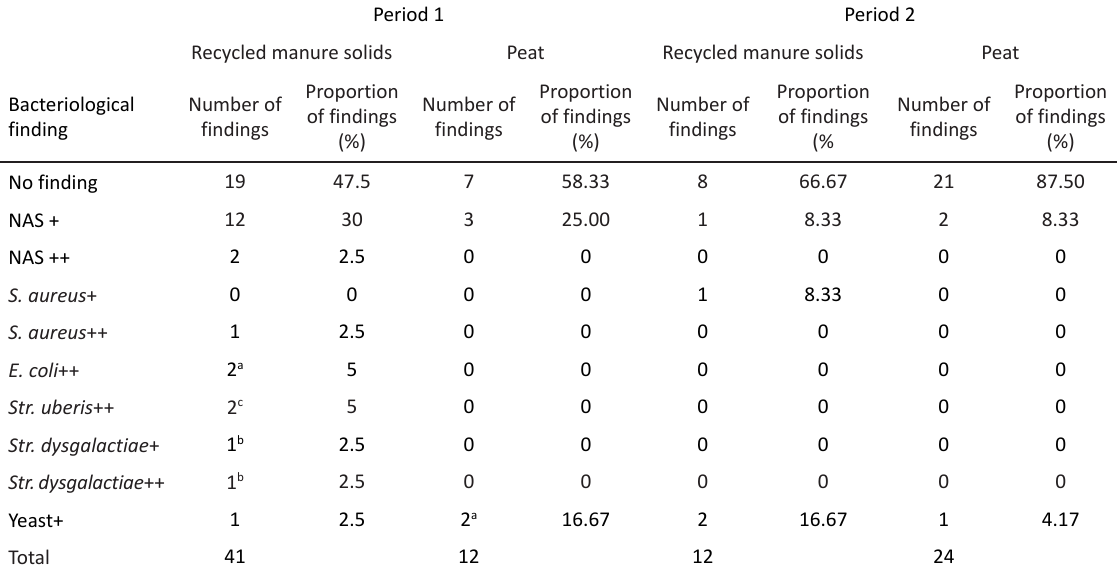
Table 8. Mastitis pathogens found during the experiment, the number of bacteriological findings in quarter milk samples and their proportion from all the bacteriological findings (RMS n=53, peat n=36) during the experiment. In total 86 quarter milk samples were taken. Three samples (n=1 in Str. uberis ++, Str. dysgalactiae + and Str. dysgalactiae ++) had multiple findings with NAS, which leads to a total of 89 findings in the